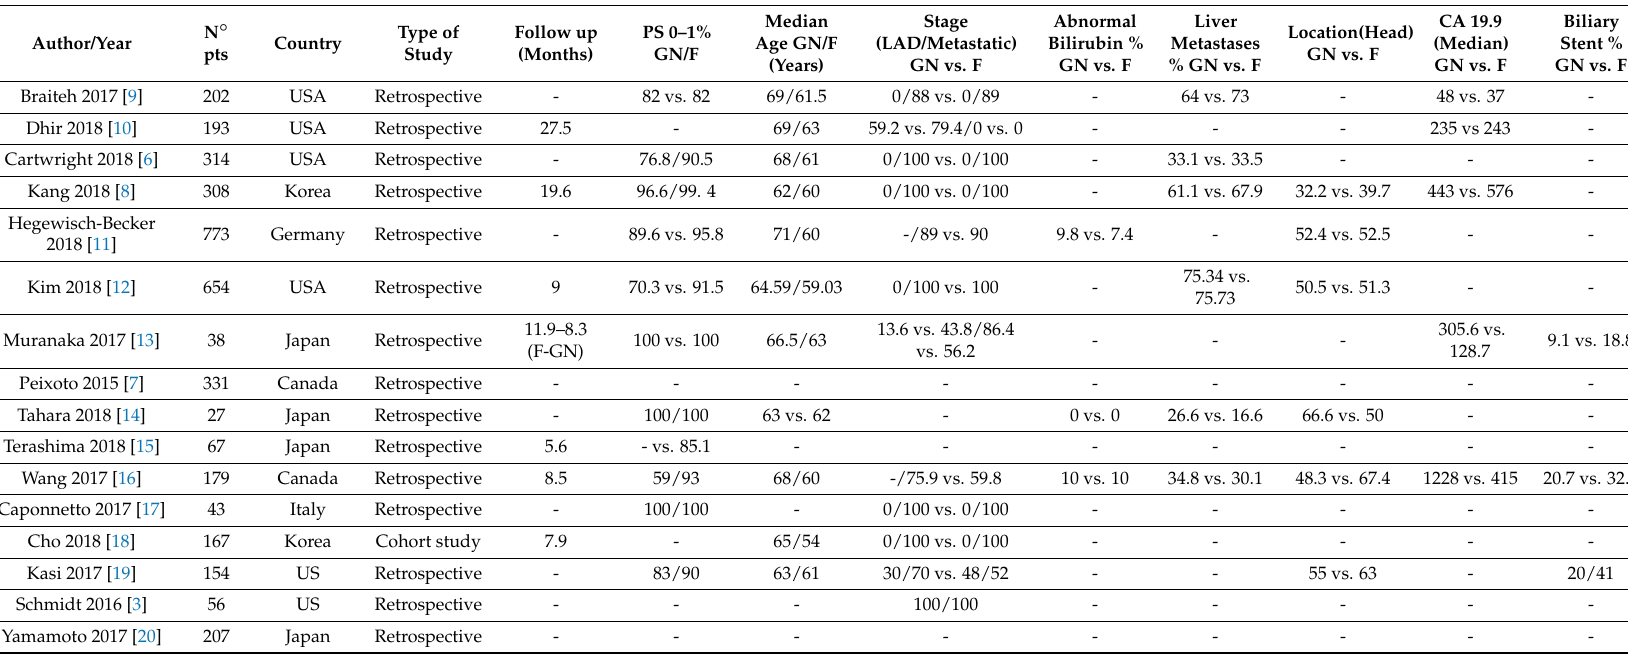
Table 1. Characteristics of included studies gemcitabine and nab-paclitaxel (GEM-NAB) vs. 5-fluorouracil, oxaliplatin, and irinotecan